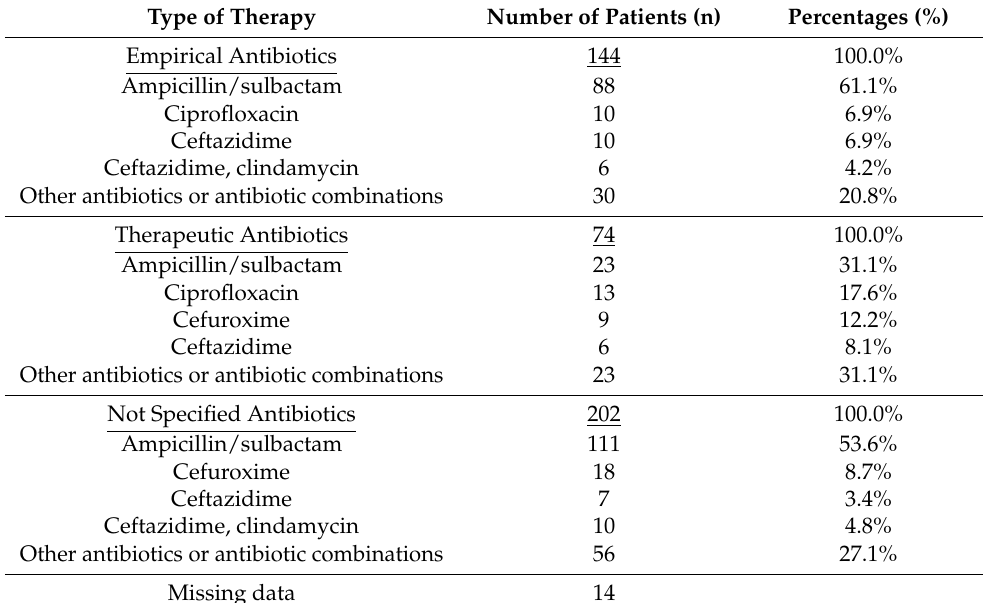
Table 6. Antibiotics prescribed for DFI